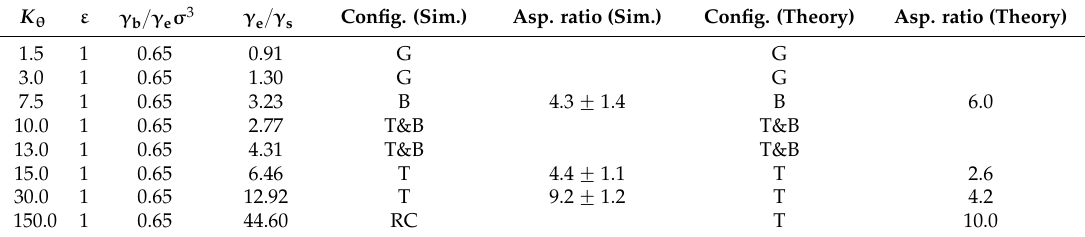
Table 1. Comparison of conformations and their corresponding aspect ratios between simulation using harmonic bending potential and theory for chain with L * = 600. Each simulation is repeated three times and the error bar is taken as the standard deviation among the three aspect ratios. The aspect ratios l * /r * and R * /r * are only shown for the bundle and torus conformations. K θ ε γ b { γ e σ 3 γ e { γ s Config. (Sim.) Asp. ratio